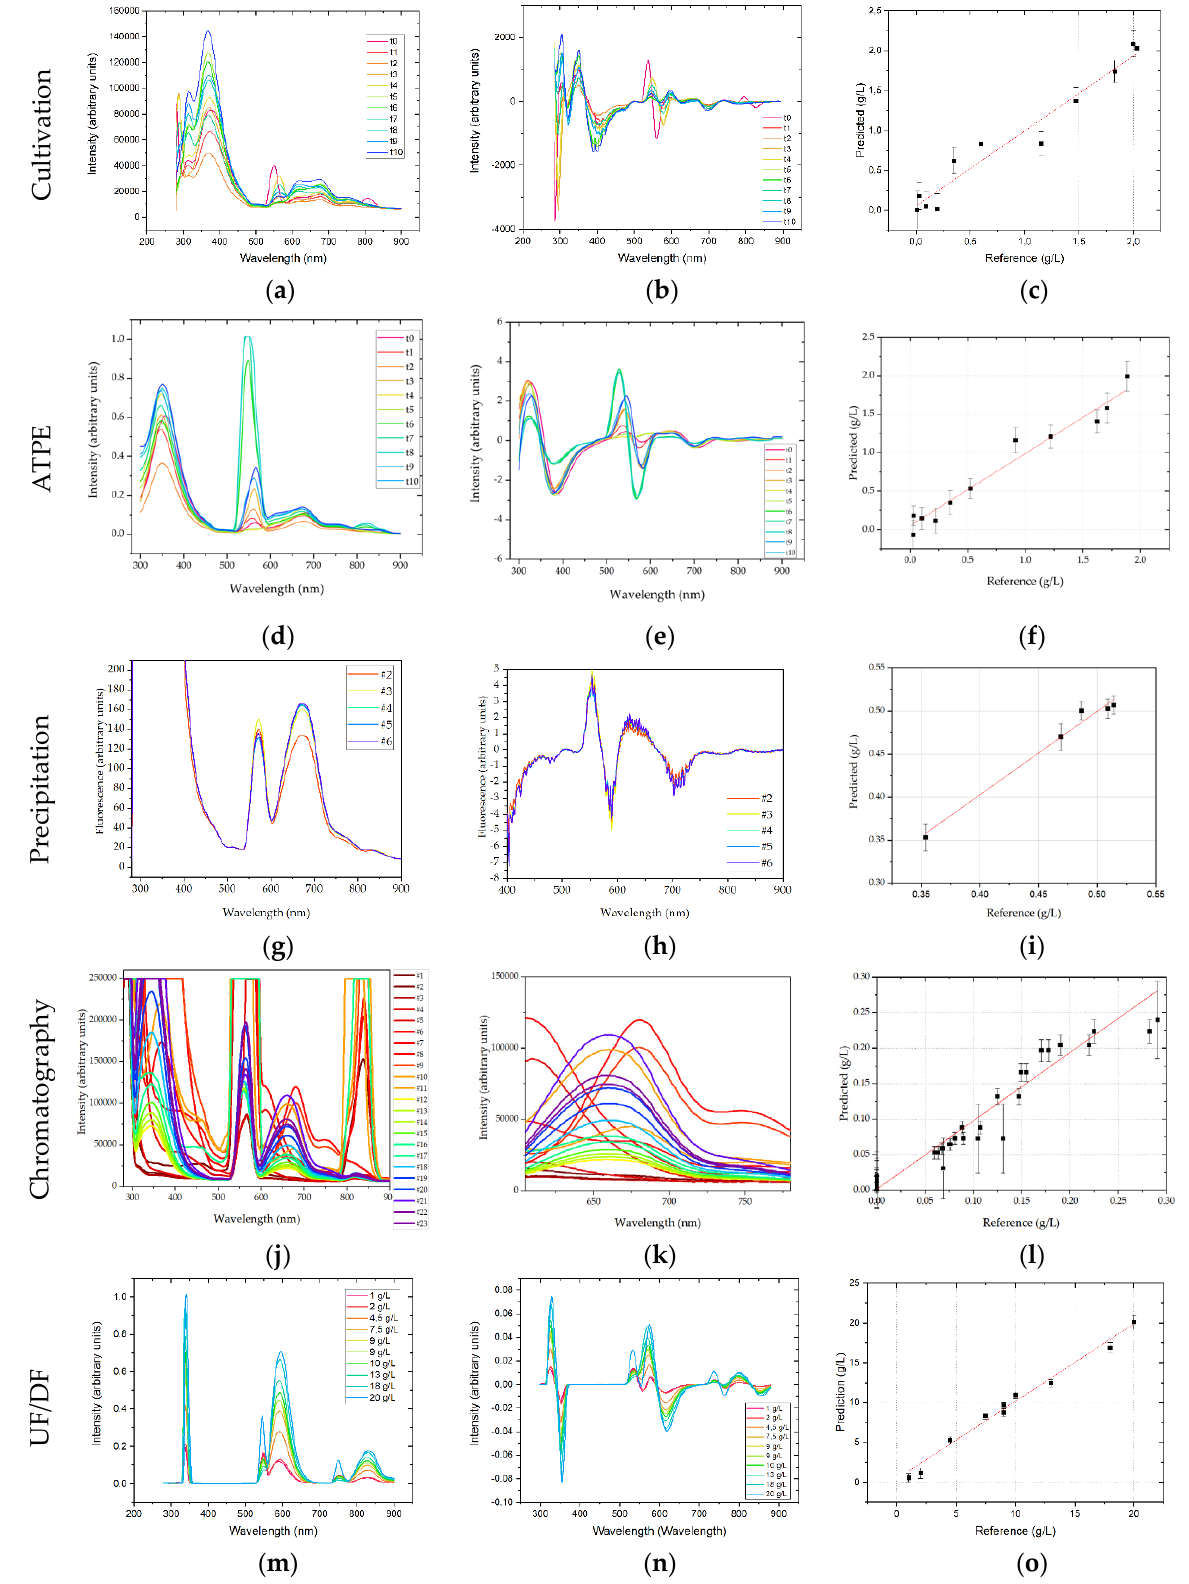
Figure 11. Fluorescence spectra: raw ( a , d , g , j , m ), after preprocessing ( b , e , h , k , n ) and PLSR results ( c , f , i , l , o ). Spectra are color-coded from high concentration (blue) to low concentration (red).